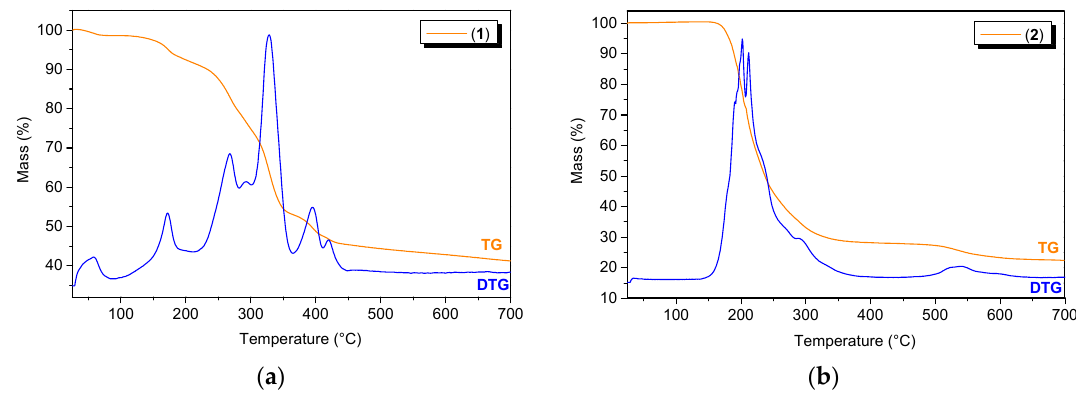
Figure 8. The TG/DTG curves for ( a ) compound 1 and ( b ) compound 2 . Figure 8. The TG / DTG curves for ( a ) compound 1 and ( b ) compound 2